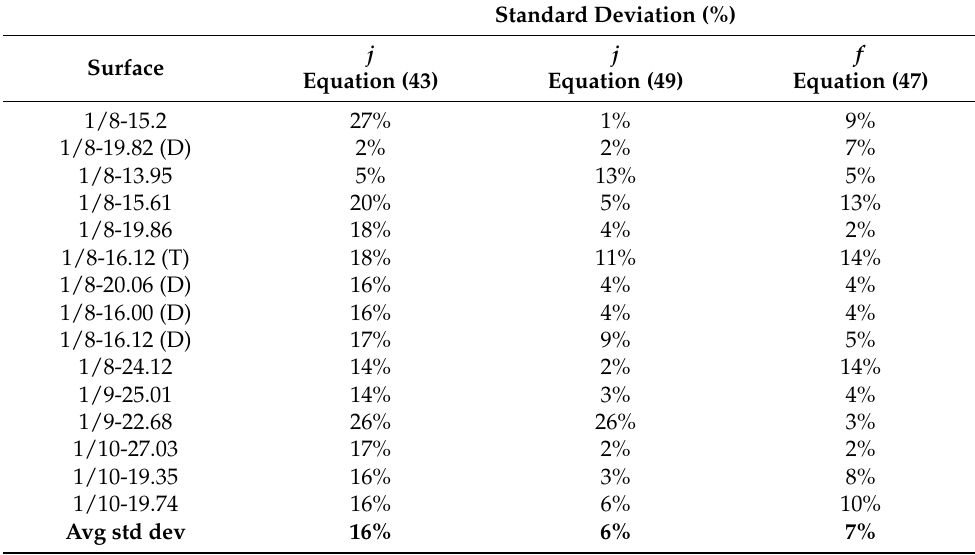
Table 5. Total average and standard deviation for Colburn and friction factor for strip-fin